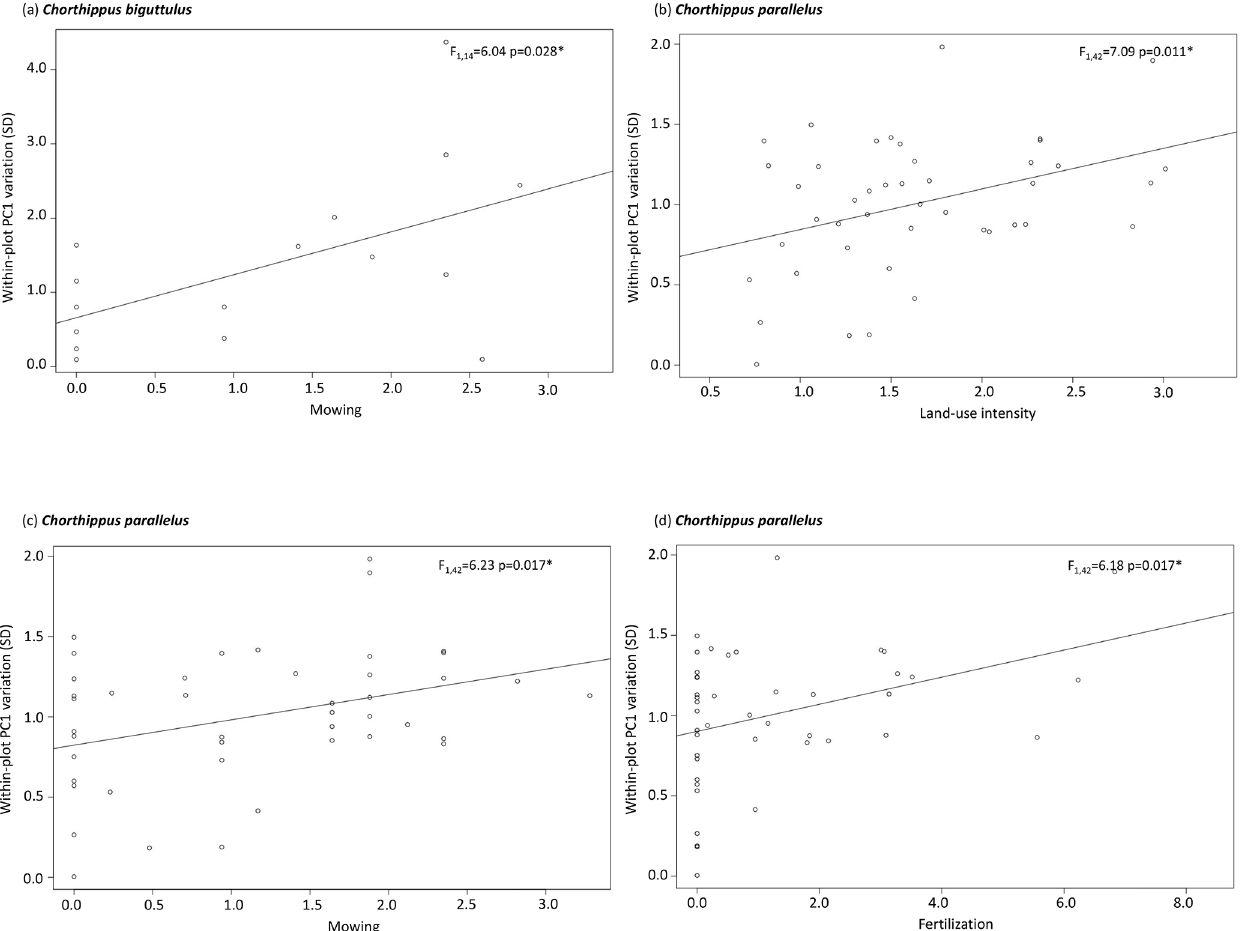
Figure 4. Within-plot variation of relative morphological PC scores in (a) Chorthippus biguttulus and (b–d) Chorthippus parallelus in relation to mowing, fertilization, and land-use index (LUI). Note the different scales. Abbreviations: ∗ = p ≤